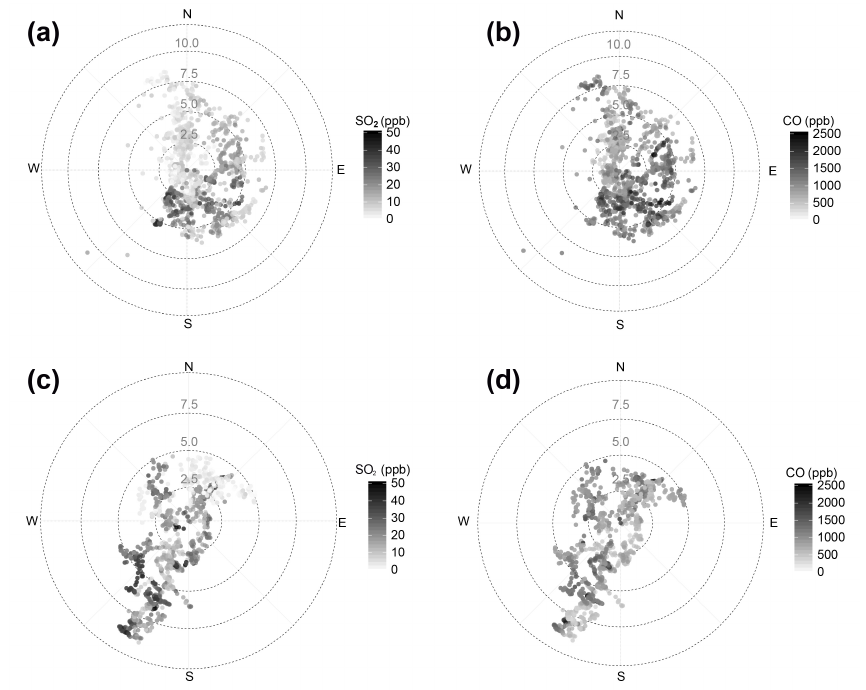
Figure 8. Wind dependency scatter plots of concentrations of SO 2 and CO in border and central areas in NCP. (a) SO 2 in border area; (b) CO in border area; (c) SO 2 in central area; (d) CO in central